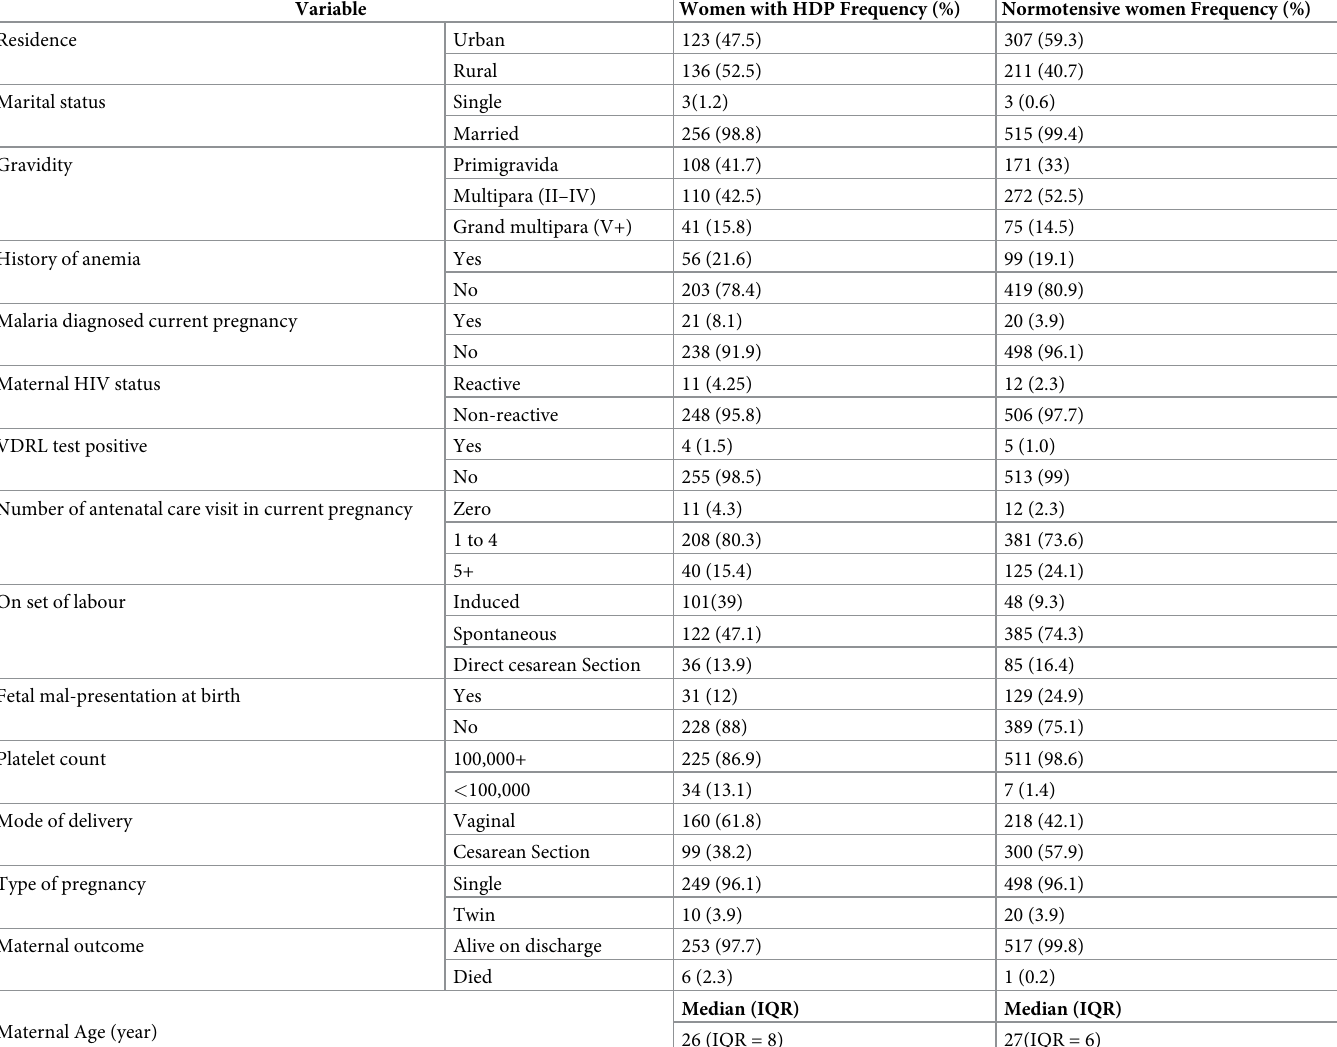
Table 1. Socio-demographic and obstetric characteristics of pregnant women who gave birth at JMC in Jimma town, southwest Ethiopia from June, 2017- March,